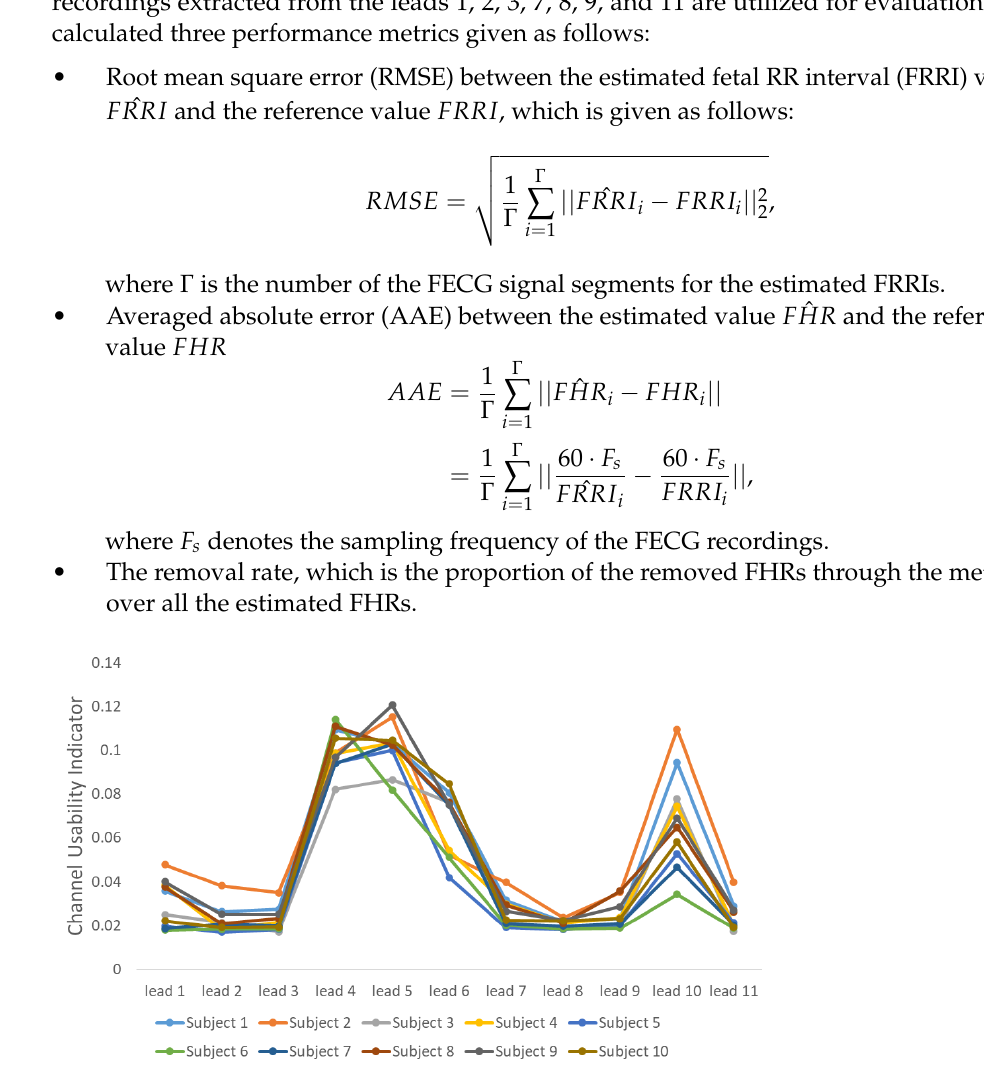
Figure 5. Channel usability evaluation. The smaller value of the channel usability indicator means the higher